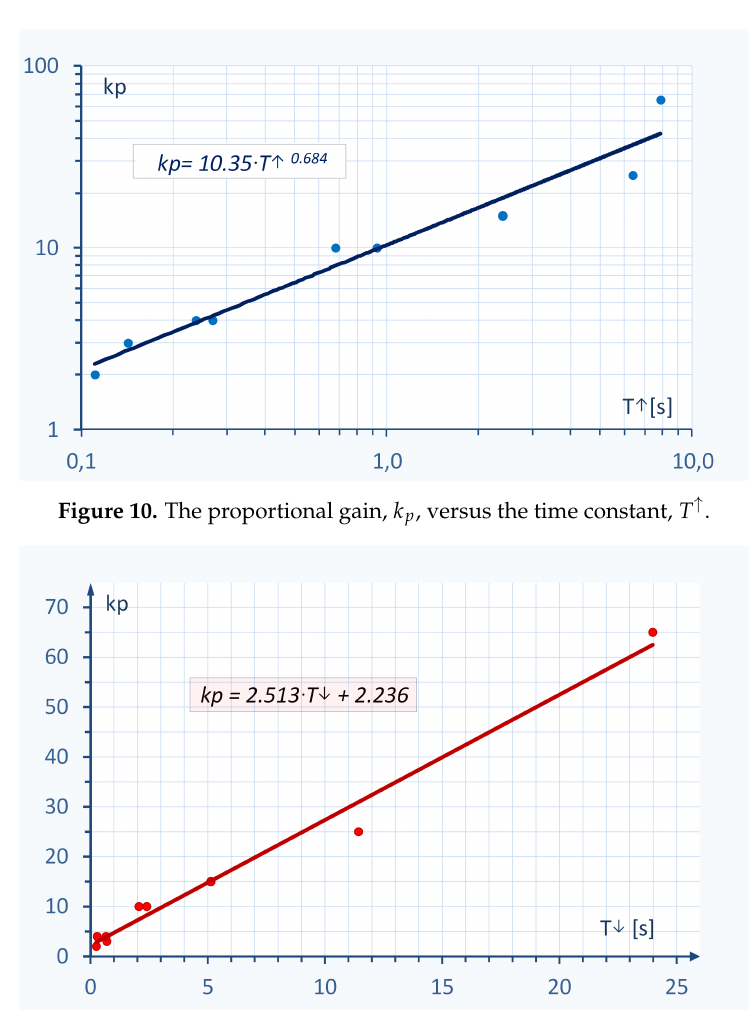
Figure 11. The proportional gain, k p , versus the time constant, T ↓